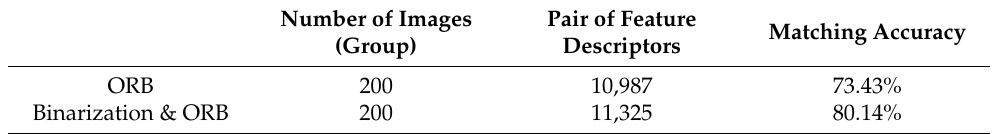
Table 3. 200 pairs of bone tag tabs match each